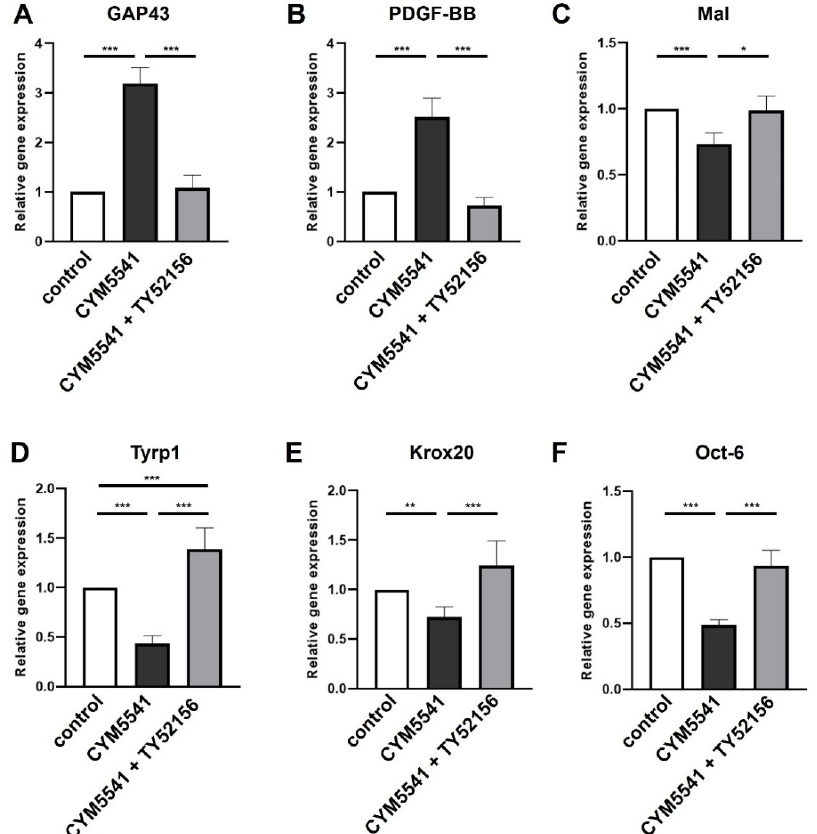
Figure 5. Specific stimulation of S1P3 enhances the Schwann cell repair phenotype. Application of